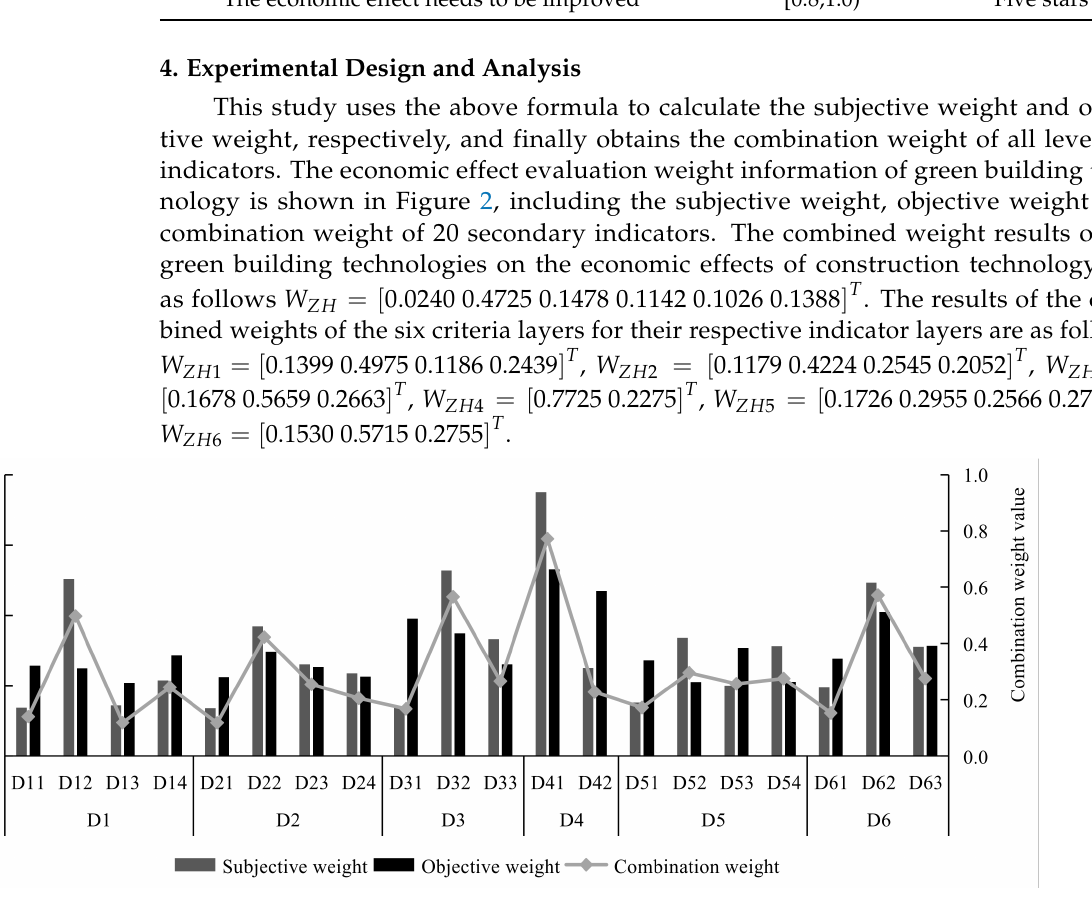
Figure 2. Weight information of economic effect evaluation of green building